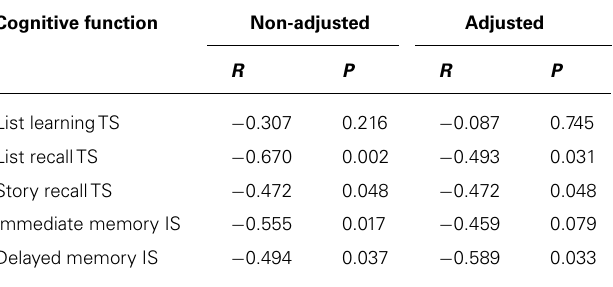
The left panel of the table illustrates the results of the regression coefficients for the changes of RNFL thickness and cognitive function in a simple linear regres- sion. The right panel of the table shows the regression coefficients in multiple linearregressionsincludingadjustmentofage, gender, education, bloodglucose, and cholesterol levels.TS, test score; IS, index